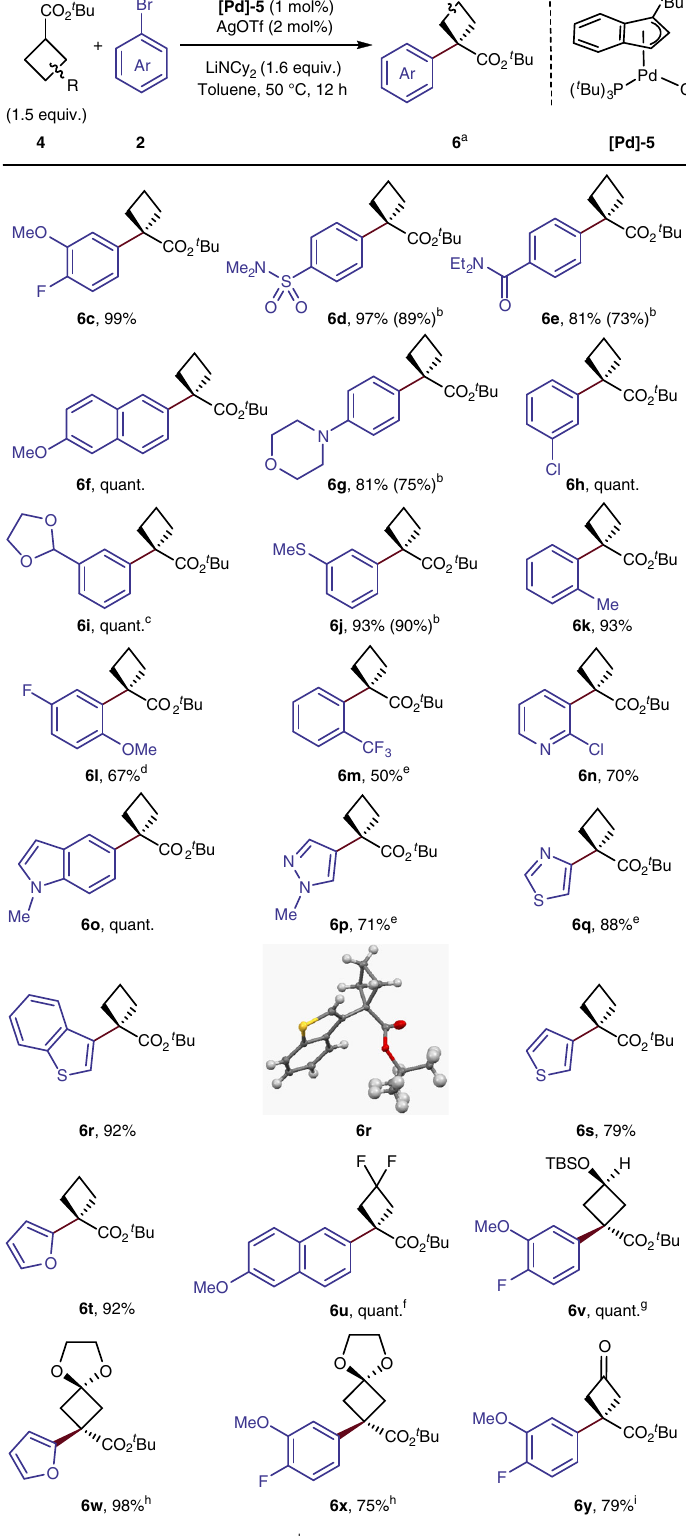
Fig. 3 Scope of α -arylation of cyclobutyl t -butyl esters. a Isolated yields. b Yield in the parentheses in 10 min. c 2 mol% [Pd] cat and AgOTf were used. d 2 mol % [Pd] cat was used. e 5 mol% [Pd] cat was used. f 5 mol% [Pd] cat was used without AgOTf. g 5 mol% [Pd] cat and AgBF 4 were used, dr 4:1, major isomer is shown. h 5 mol% [Pd] cat and AgBF 4 , ester (2 equiv.), LiNCy 2 (2.1 equiv.) at 65 ° C were used. i From 6u through hydrolysis. TBS: tert